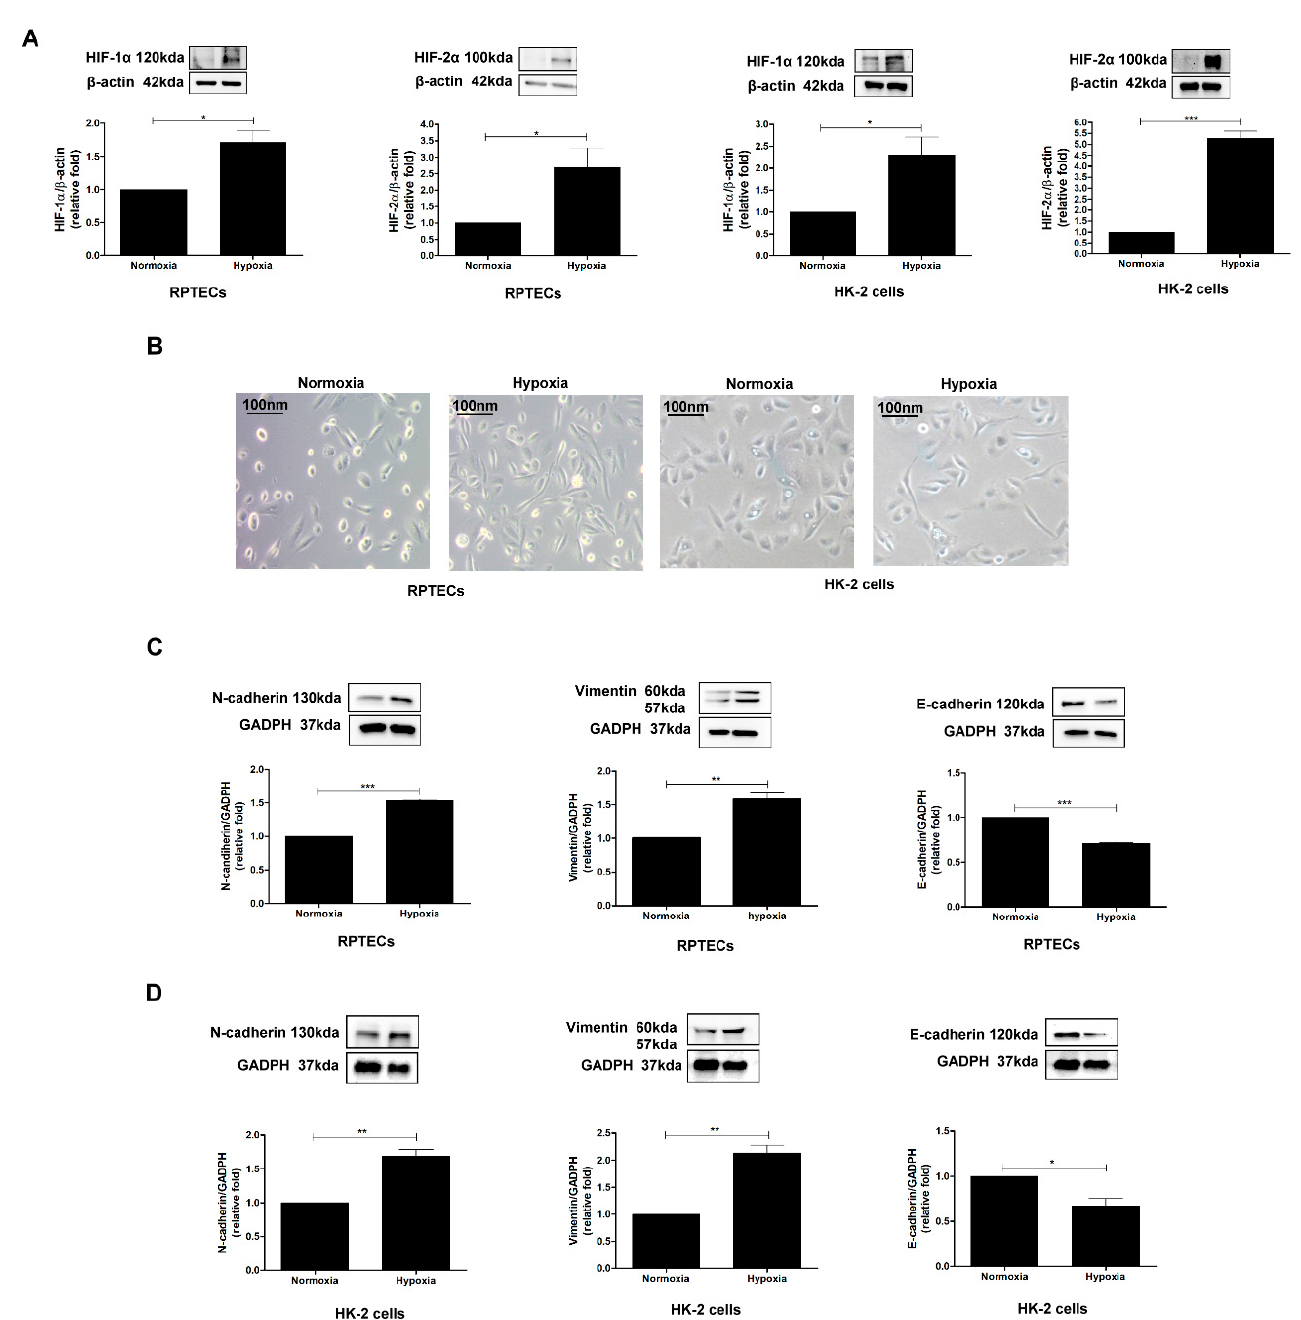
Figure 1. Hypoxia induces EMT in PTECs. ( A ) HIF-1 α and HIF-2 α expression were assessed in RPTECs and HK-2 cells were incubated under normoxia (O 2 , 21%) and hypoxia (O 2 , 1%) conditions for 6 h using Western blotting. ( B ) The effect of hypoxia on morphological changes in RPTECs and HK-2 cells under normoxia and hypoxia conditions for 48 h. EMT markers (E-cadherin, N-cadherin, and vimentin) were examined in human RPTECs ( C ) and HK-2 cells ( D ) treated with normoxia and hypoxia for 48 h using Western blotting. The bar graph represents the mean ± SEM of at least three independent experiments. * p < 0.05, ** p < 0.01, *** p < 0.001 by Student’s t -test.